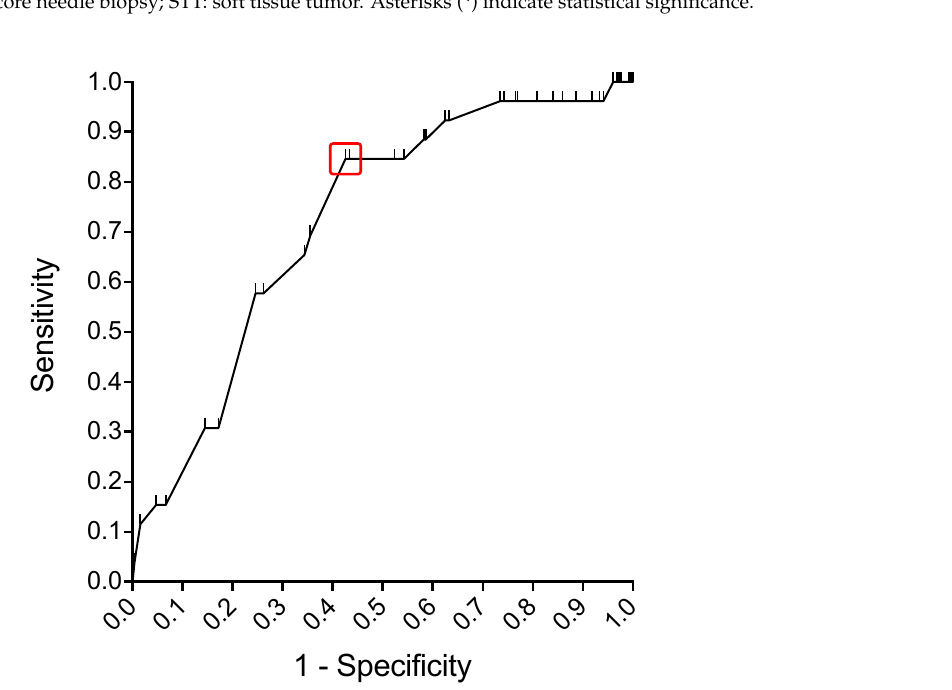
Figure 3. ROC curve for determination of an optimal lesion size cut off value to separate patients with conclusive CNB from patients with inconclusive CNB (red marker, sensitivity 84.6%, specificity 57.4%, Youden index 0.42).